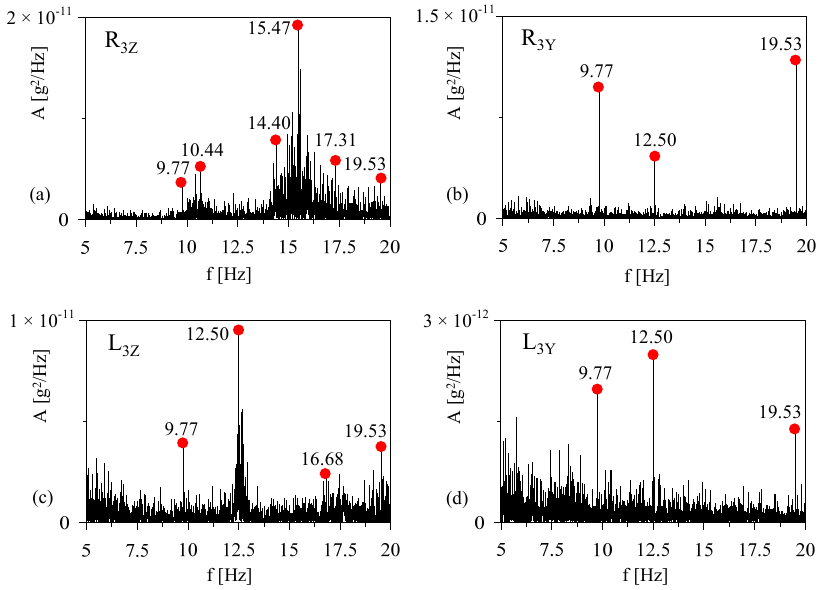
Figure 9. PSDs related to the time histories illustrated in Figure 8: ( a ) R 3Z , ( b ) R 3Y , ( c ) L 3Z , and ( d ) L 3Y . Table 2. Peak values shown by the PSDs of Figure 9 associable to structural modes.